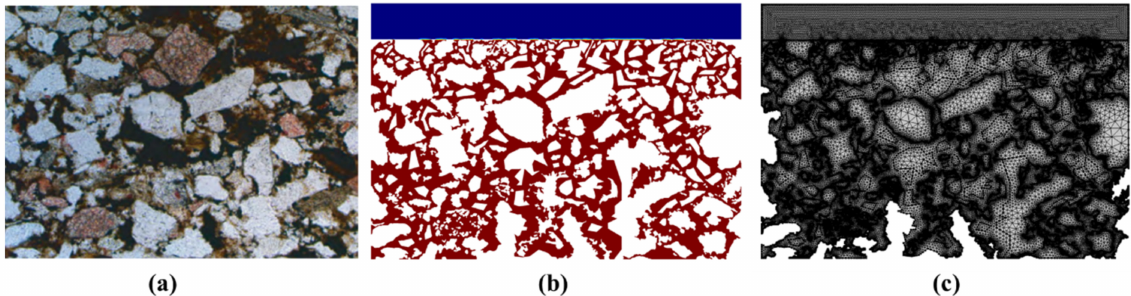
Figure 3. Actual rock structure model. ( a ) Scanning electron microscope image [35]. ( b ) Initial oil and water distribution (blue area represents water and red area represents oil). ( c ) Triangular